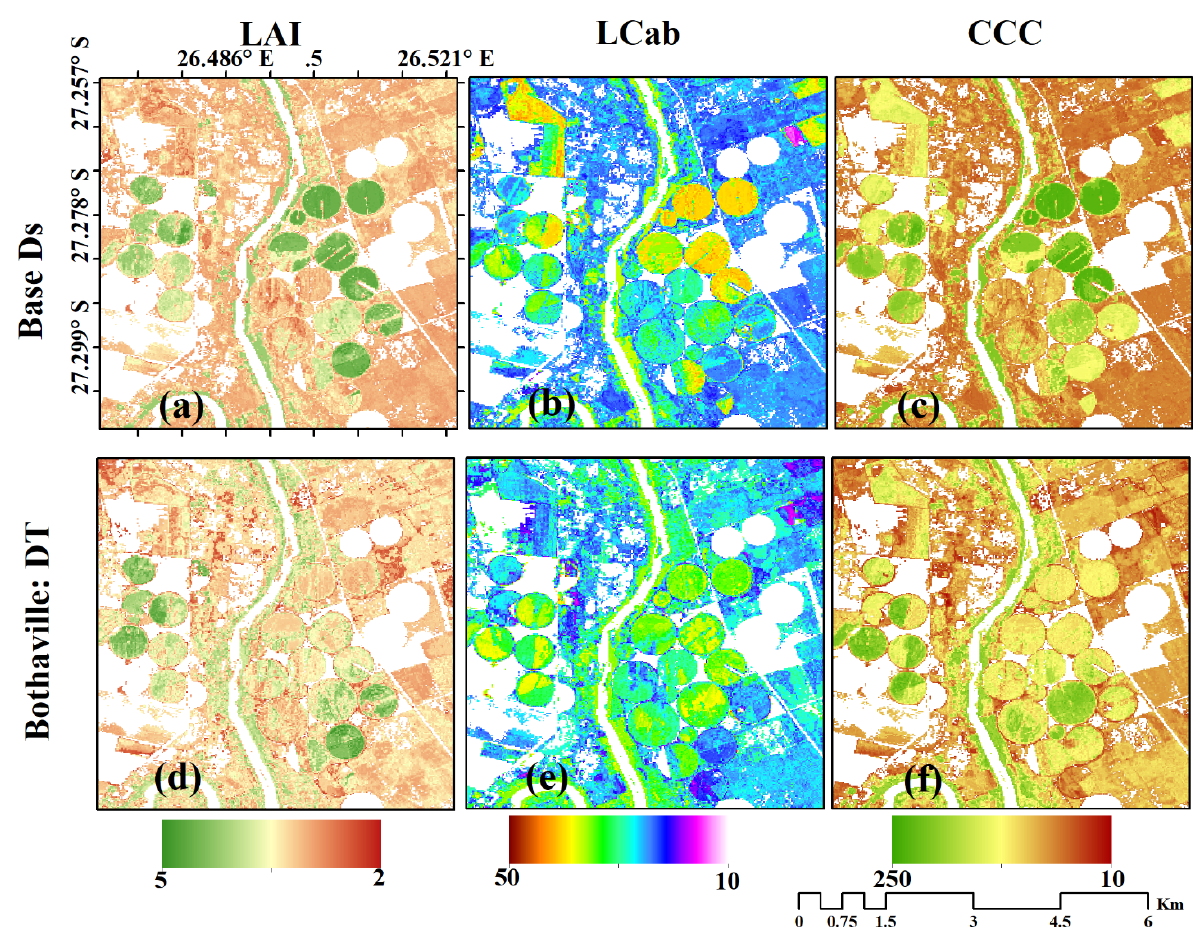
Figure 6. Spatial distribution maps of LAI (i.e., ( a , d )), LC ab (i.e., ( b , e )), and CCC (i.e., ( c , f )) retrieved using XGBoost and Sentinel-2. ( a – c ) were retrieved with Bothaville Source (i.e., Base D S ) models, while ( d – f ) were retrieved with transferred models to Bothaville D T (i.e., Harrismith ( D S ) → Bothaville ( D T )) that achieved superior transferability, i.e., Base D S + 75% for LAI ( d ) and Base D S + 25% for LC ab ( e ) and CCC ( f ).